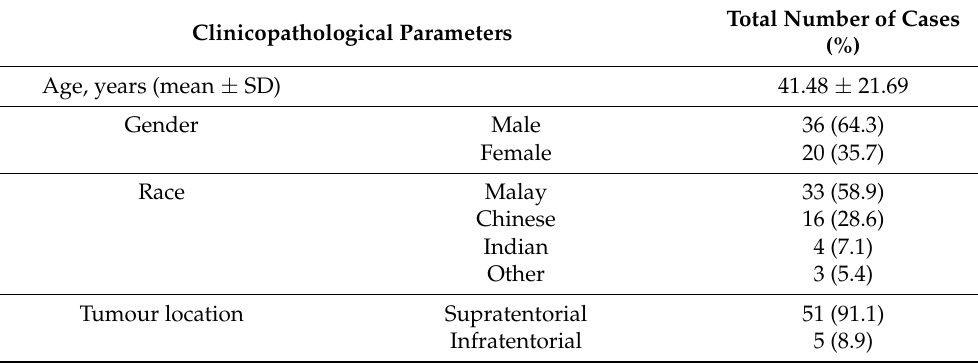
Table 1. Clinicopathological parameters of the study